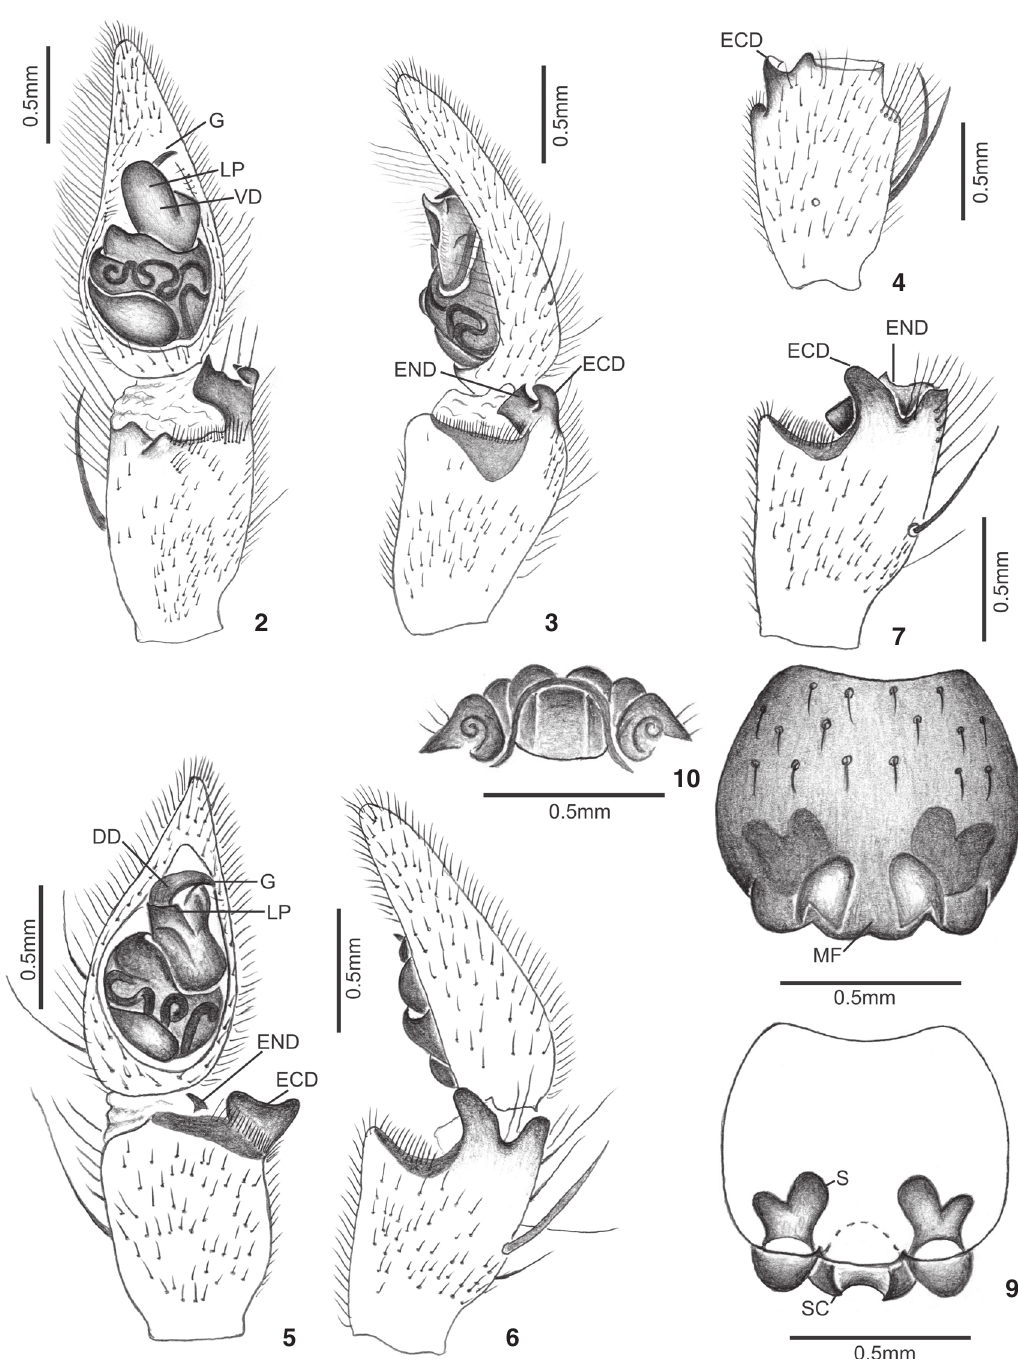
Figures 2-10. Carilea apurimac sp. nov. , male palpus: (2) ventral view. (3) retrolateral view. (4) dorsal view (detail of retrolateral apophy- (8-10) E. echarate sp. nov. , female epigynum: (8) ventral view; (9) dorsal view; (10) posterior view. (ECD) Ectal division of RTA, (END) ental division of RTA, (G) guide, (LP) lamellar projection, (MF) middle field of epigynum, (RTA) retrolateral tibial apophysis, (S) sper- matheca, (SC) scape, (VD) ventral division of median